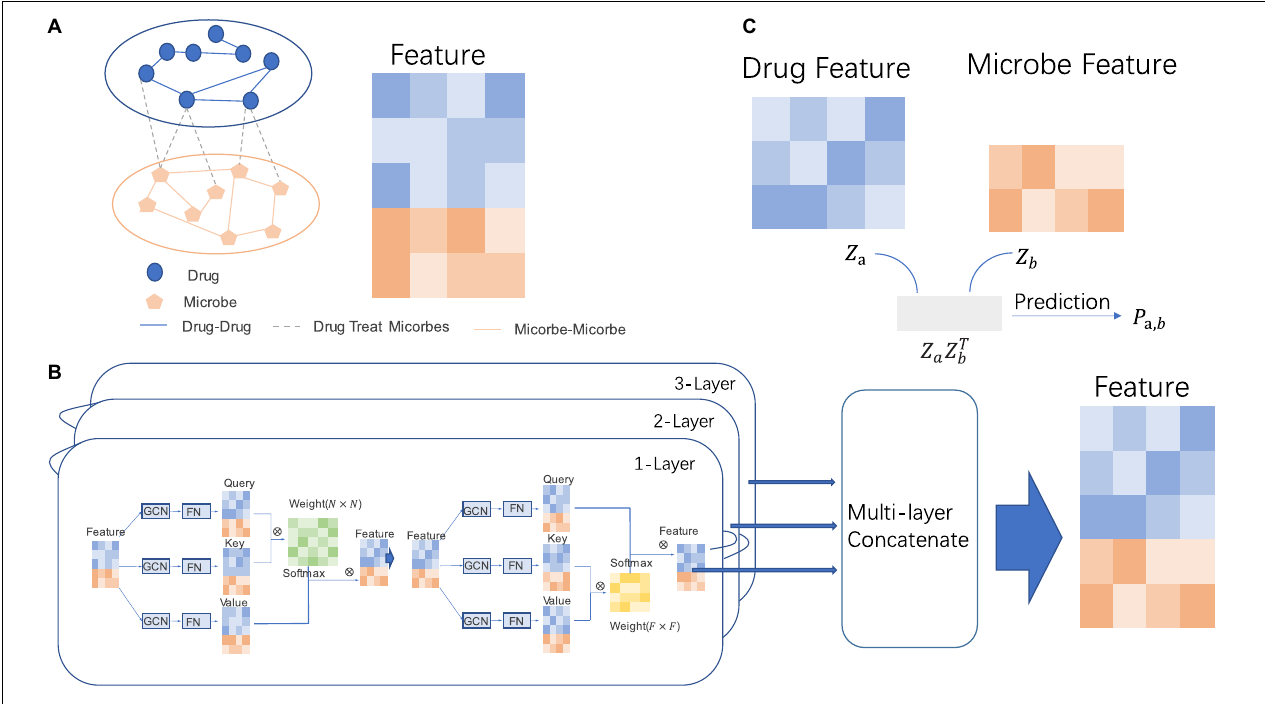
FIGURE 1 | The specific process of MDGNN. (A) Microbiome-drug network. The entire network is composed of three subnetworks, namely, the interaction network between drugs and drugs, the interaction network between microorganisms, and the associated network between drugs and microorganisms. (B) Graph neural networks of two attentional mechanisms. Through the graph convolution operation on the node feature and the graph structure and the feature projection of the fully connected function, the projection of the three-node features can be obtained, which can be used to calculate the attention weight matrix between nodes and the node feature of attention between feature components, so as to calculate the final node representation features. (C) Prediction of potential associations between microorganisms and drugs. Through the inner product of the learned node representations, the prediction score between the drug feature and microbe feature can be obtained, so as to determine whether there is an association between the node